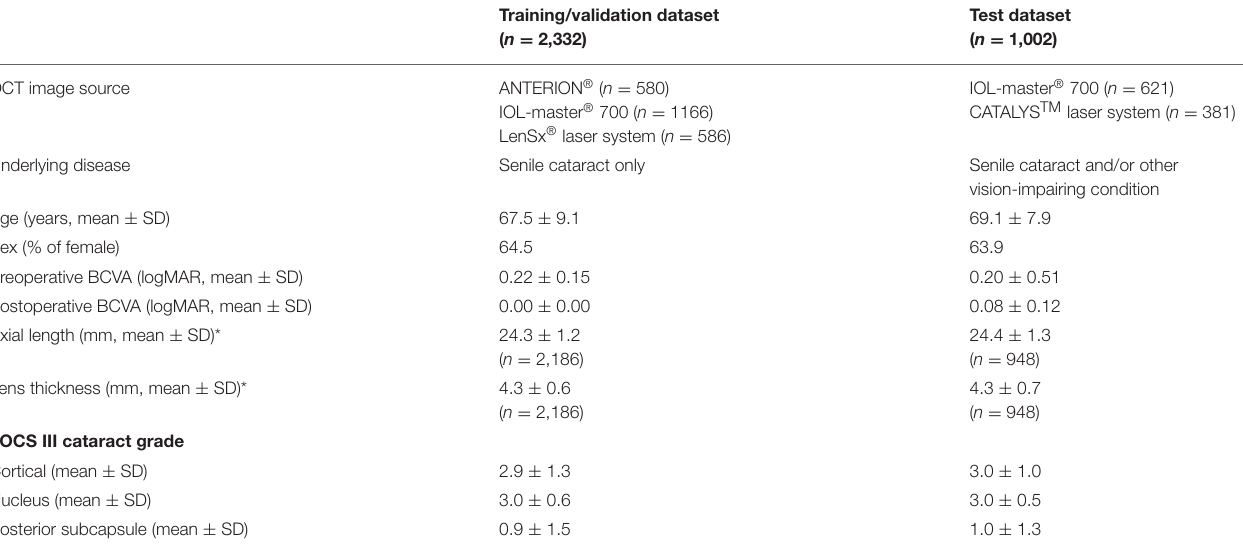
TABLE 1 | Demographics and characteristics of the training/validation dataset and test